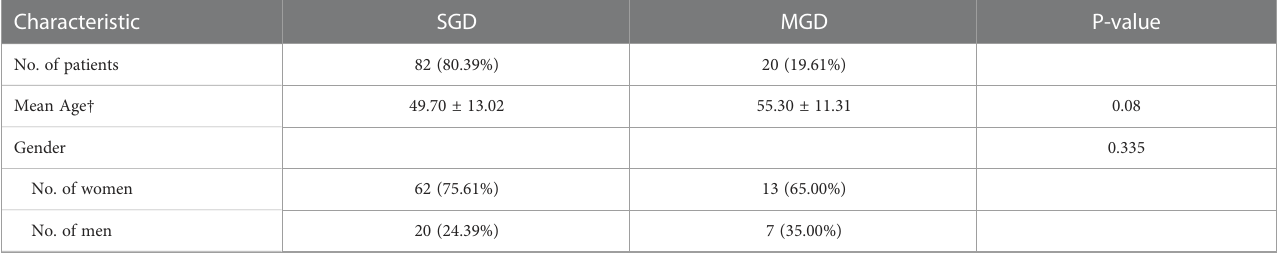
TABLE 1 Demographic and Clinical Characteristics of Patients With